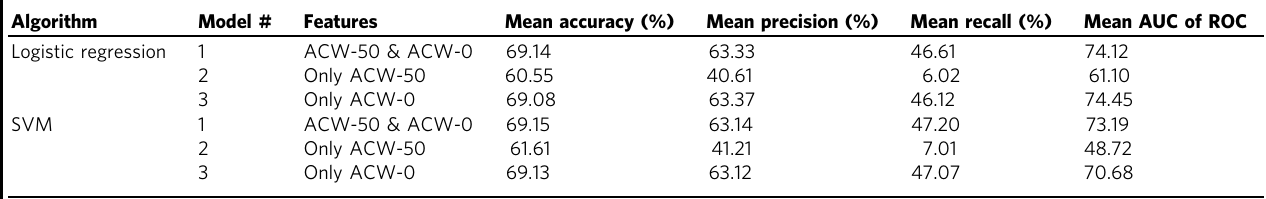
Table 3 The results for the 2-class classi fi cation